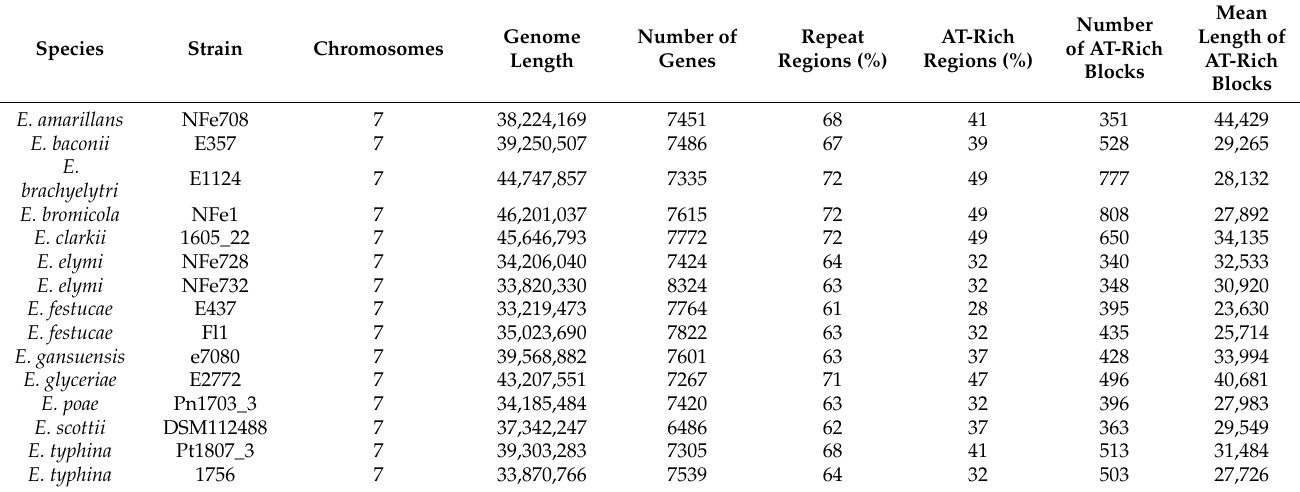
Table 2. Genomic characteristics of the 15 Epichloë